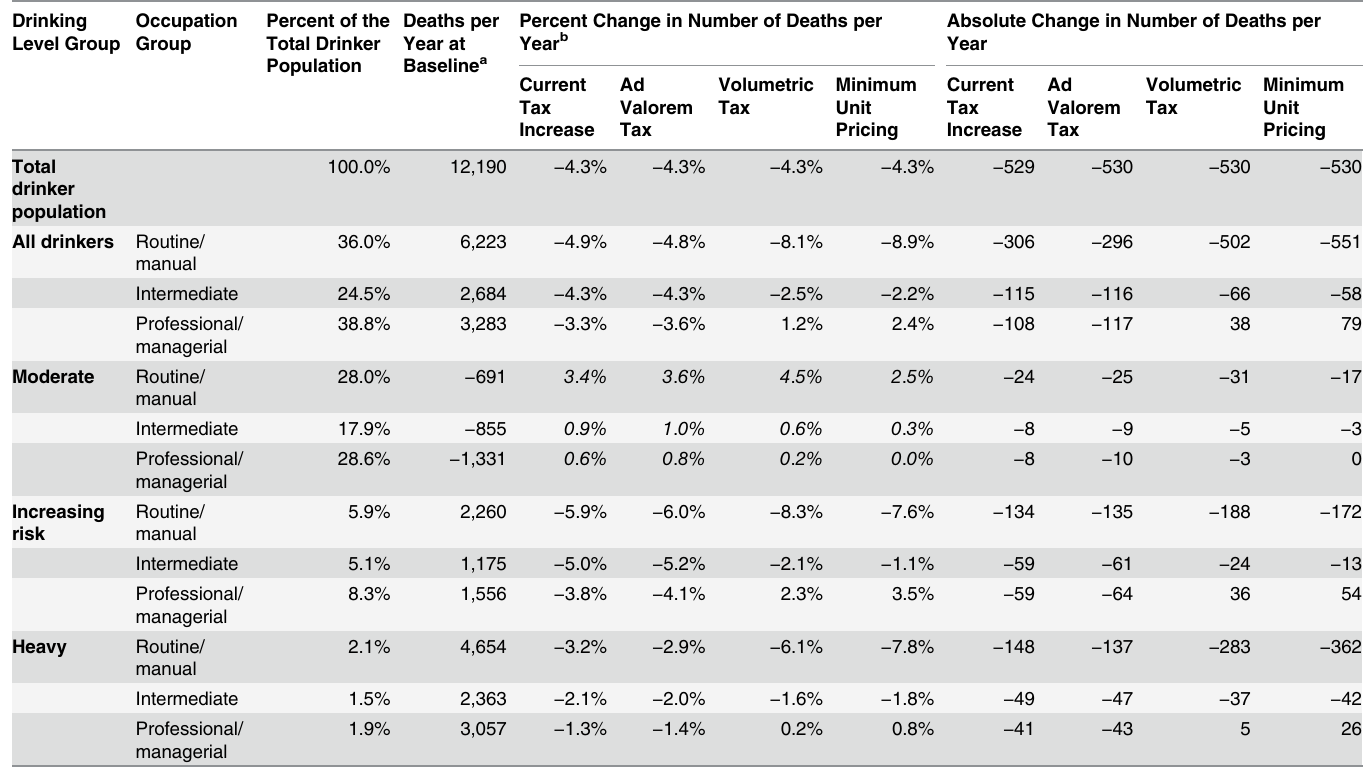
Table 5. Annual full effects of policies on alcohol-related deaths, by drinking level and socioeconomic